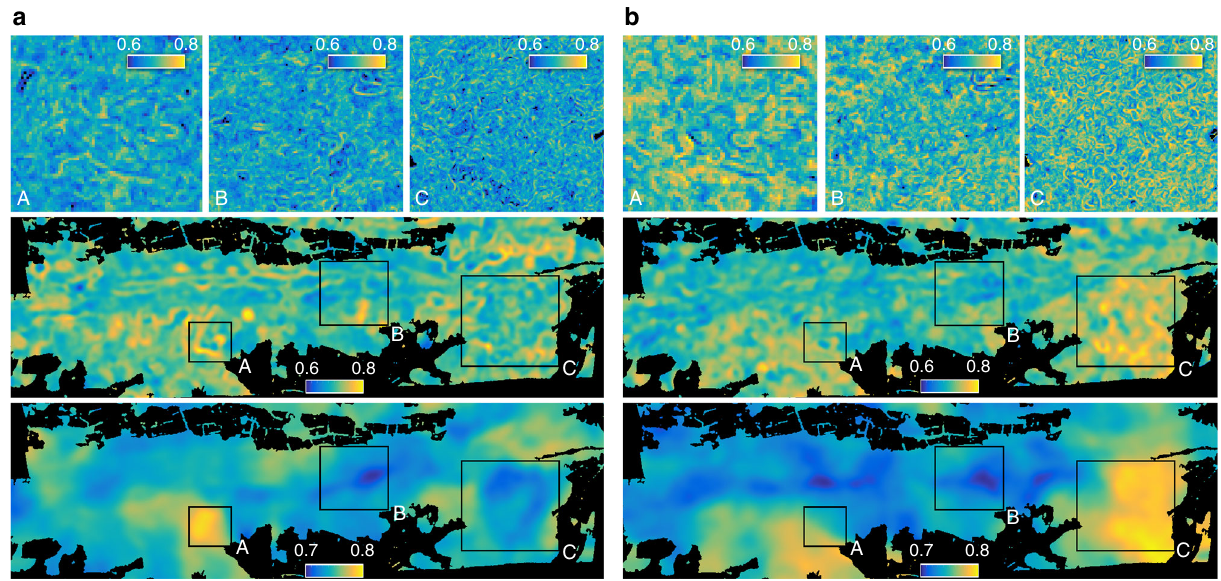
Fig. 6 Spatial patterns of morphological and physiological divergence at three different scales. Functional divergence was computed at 12 m (top), 60 m (middle) and 240 m (bottom) radius based on a morphological traits and b physiological traits. At 12 m radius (top panels), subregions A, B and C are plotted only. The colour is scaled from the lowest (dark blue) to the highest (yellow) divergence value with a maximum possible range from 0 to